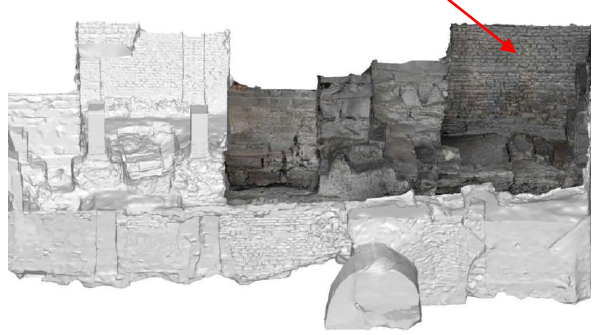
Figure 7. Basement of the Chapel: 3D mesh and textured model foundations under and outside the Nord side aisle of the cathedral, with the “1015 wall” on the right (red arrow).